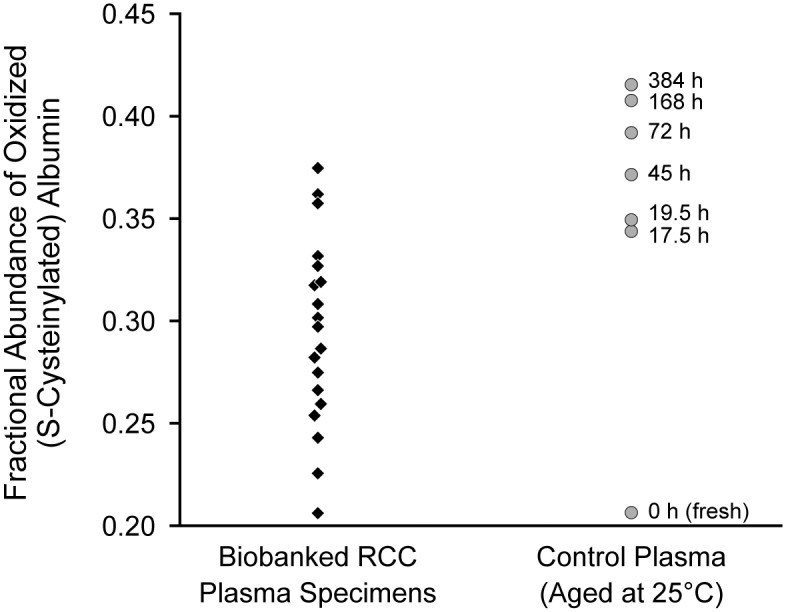
Albumin Oxidation (S-Cysteinylation) Observed in the Banked Renal Cell Carcinoma (RCC) Plasma Samples.Control plasma was freshly collected from a nominally healthy donor, and albumin oxidation levels were observed at 25°C Significantly less albumin oxidation was observed in samples from patients with RCC compared with albumin in plasma kept at 25°C for ≥17.5 hours (P<.001; Mann-Whitney U test). (Data from Borges CR et al [12].)